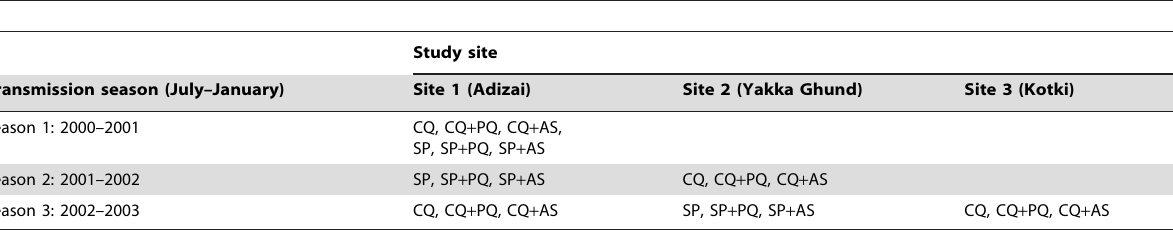
Table 1. Summary of treatment arms tested at each of the study sites over the three transmission